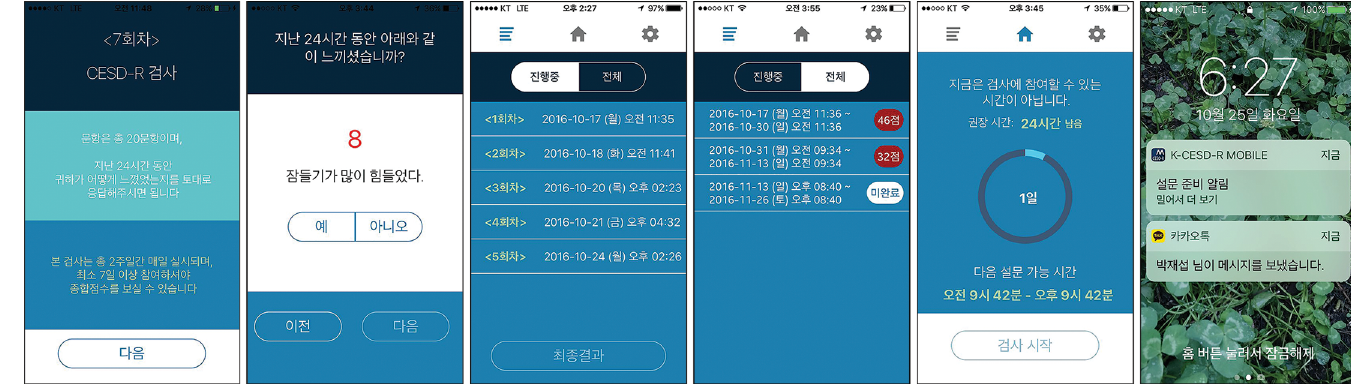
Fig 1. Screenshots of UI/GUI design of the K-CESD-R Mobile app.